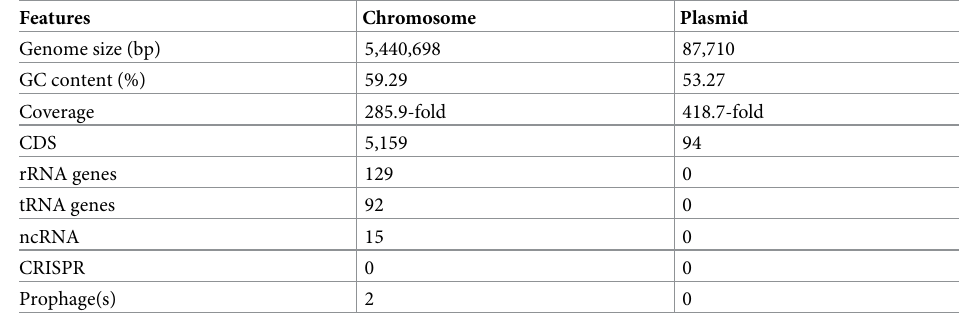
Table 2. Genome statistics of the LVF3 R chromosome and p87710